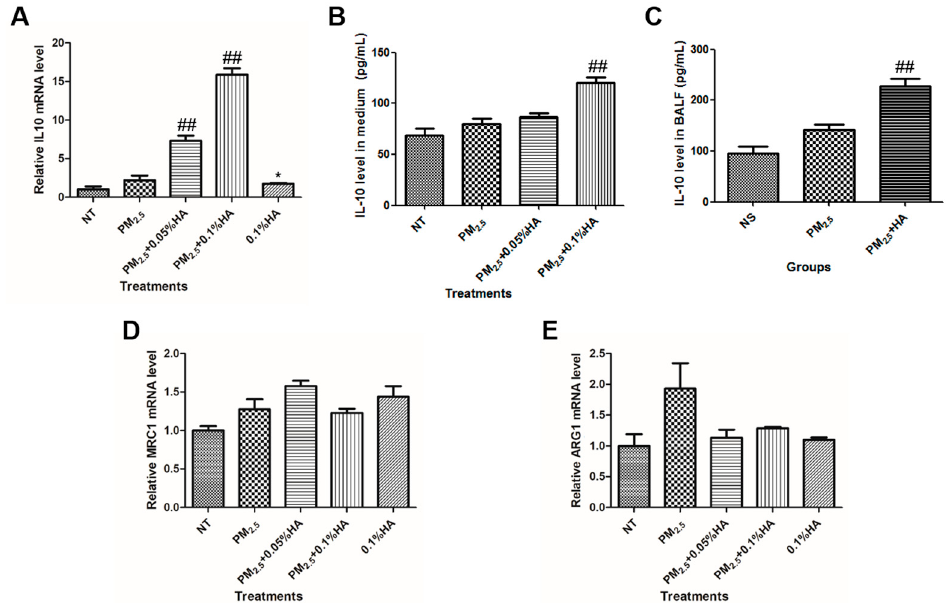
Figure 5. Upregulation of IL-10 in response to co-stimulation of PM 2.5 and HMW-HA. ( A ) NR8383 cells were stimulated by PBS, PM 2.5 , 0.1%HMW-HA, PM 2.5 and 0.05% HMW-HA, or PM 2.5 and 0.1% HMW-HA simultaneously for 6 h, and IL10 mRNA level was determined. ( B ) The secretion of IL-10 by NR8383 cells 24 h after indicated treatments was assessed by ELISA. ( C ) Rats were exposed to NS, PM 2.5 or PM 2.5 + 0.2% HA for three consecutive days by intratracheal instillation, and the concentration of IL-10 in BALF was measured by ELISA. ( D , E ) The mRNA levels of MRC1 and ARG1 in NR8383 cells were tested after indicated treatments. Data from in vitro study were presented as mean ± SD, and represent three independent experiments. Data from in vivo study were presented as mean ± SEM (N = 6). * p < 0.05, compared with the NT group or the NS group. ## p < 0.01, cells or rats exposed to PM 2.5 alone.